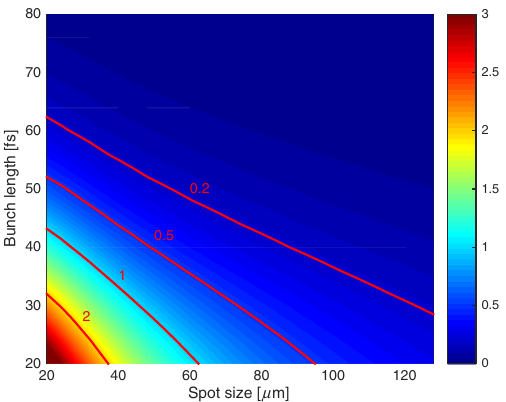
FIG. 6. The ratio of the energies of the CTR HF over LF. The color denotes the ratio value and the red solid line denotes the contour